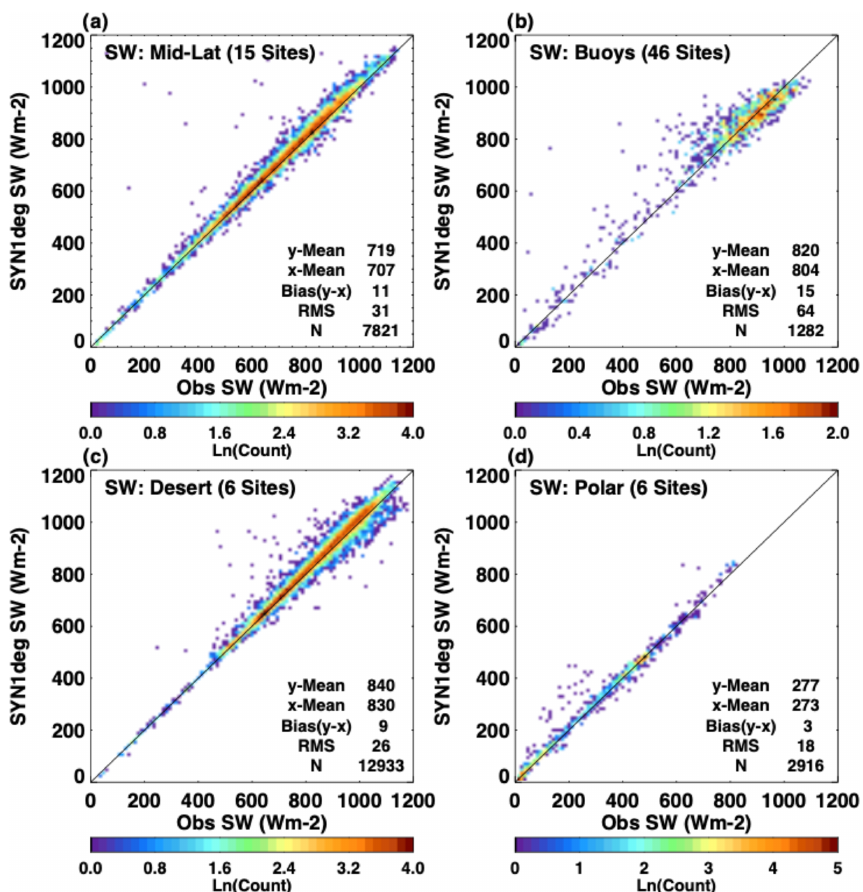
Figure 13. Comparisons of DSI at the surface from the SYN1deg Edition 4.1 calculations ( y axis for all plots) and Baseline Surface Radiation Network (BSRN) and buoy surface sites ( x axis all plots). Data are from March 2000 through February 2020 and only include hours when a 1 ◦ grid box is 100% clear sky according to the SYN1deg cloud